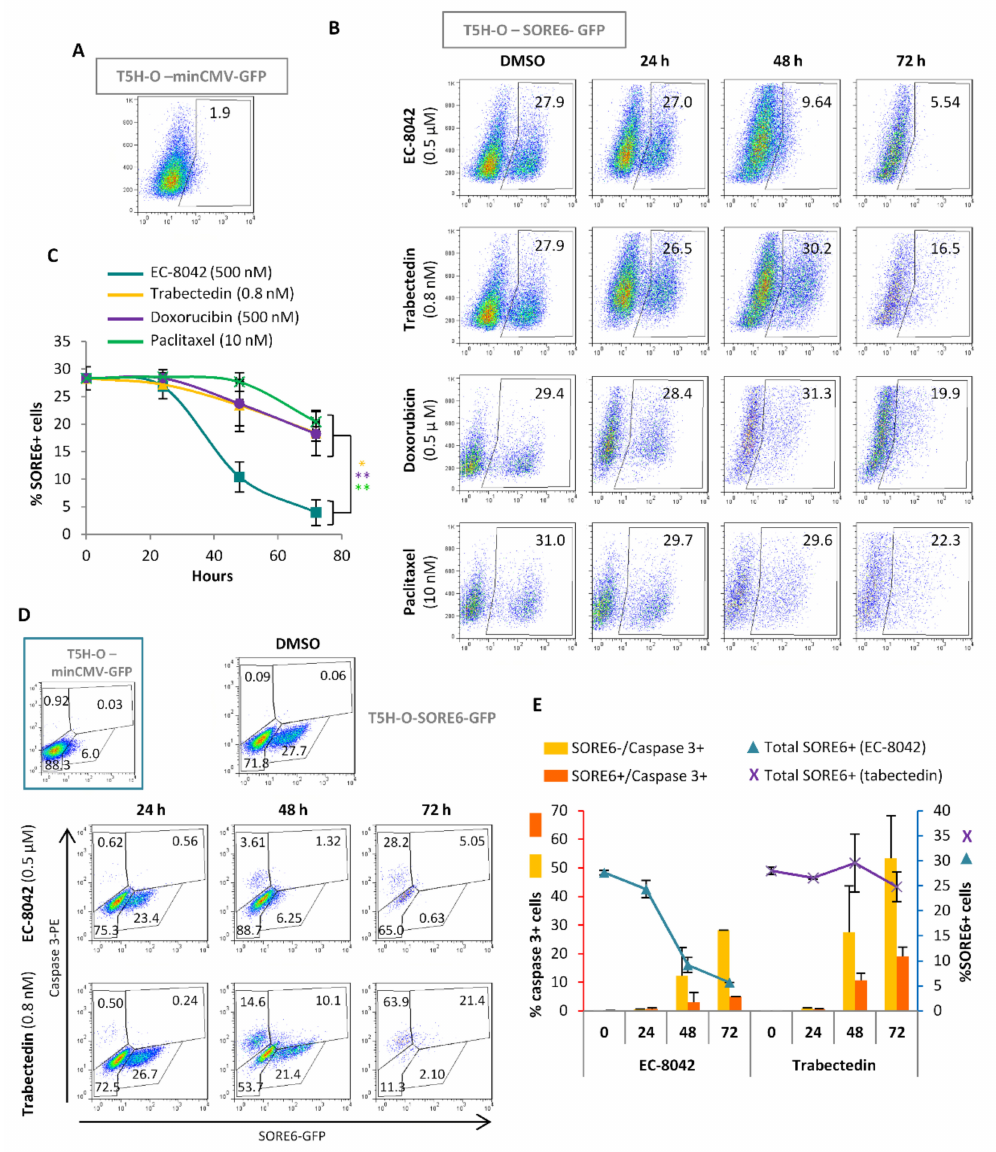
Figure 6. Di ff erential e ff ects of anti-tumor drugs on SORE6 positive cells. ( A – C ) Time course analysis of SORE + cells during drug treatment. ( A , B ) Representative flow cytometry analysis of the SORE6 + population in untreated T5H-O-minCMV-GFP (gating control) ( A ) or in T5H-O-SORE6-GFP cells treated for with 0.5 µ M EC-8042, 0.8 nM trabectedin, 0.5 µ M doxorubicin or 10 nM paclitaxel for the indicated times ( B ). ( C ) Graph showing the mean ± standard deviation of three independent experiments. Asterisks indicate statistically significant di ff erences with the EC-8042 series at 72 h (*: p < 0.05, **: p < 0.005; two-sided Student t test). ( D , E ) Biparametric flow cytometry analysis of SORE-GFP and active-caspase 3 levels. ( D ) Representative analysis in untreated T5H-O-minCMV-GFP (gating control, inset) or in T5H-O-SORE6-GFP cells treated with Trabectedin (0.8 nM) or EC-8042 (0.5 µ M) for the indicated times. ( E ) Graphic representation of three independent experiments (mean ± standard